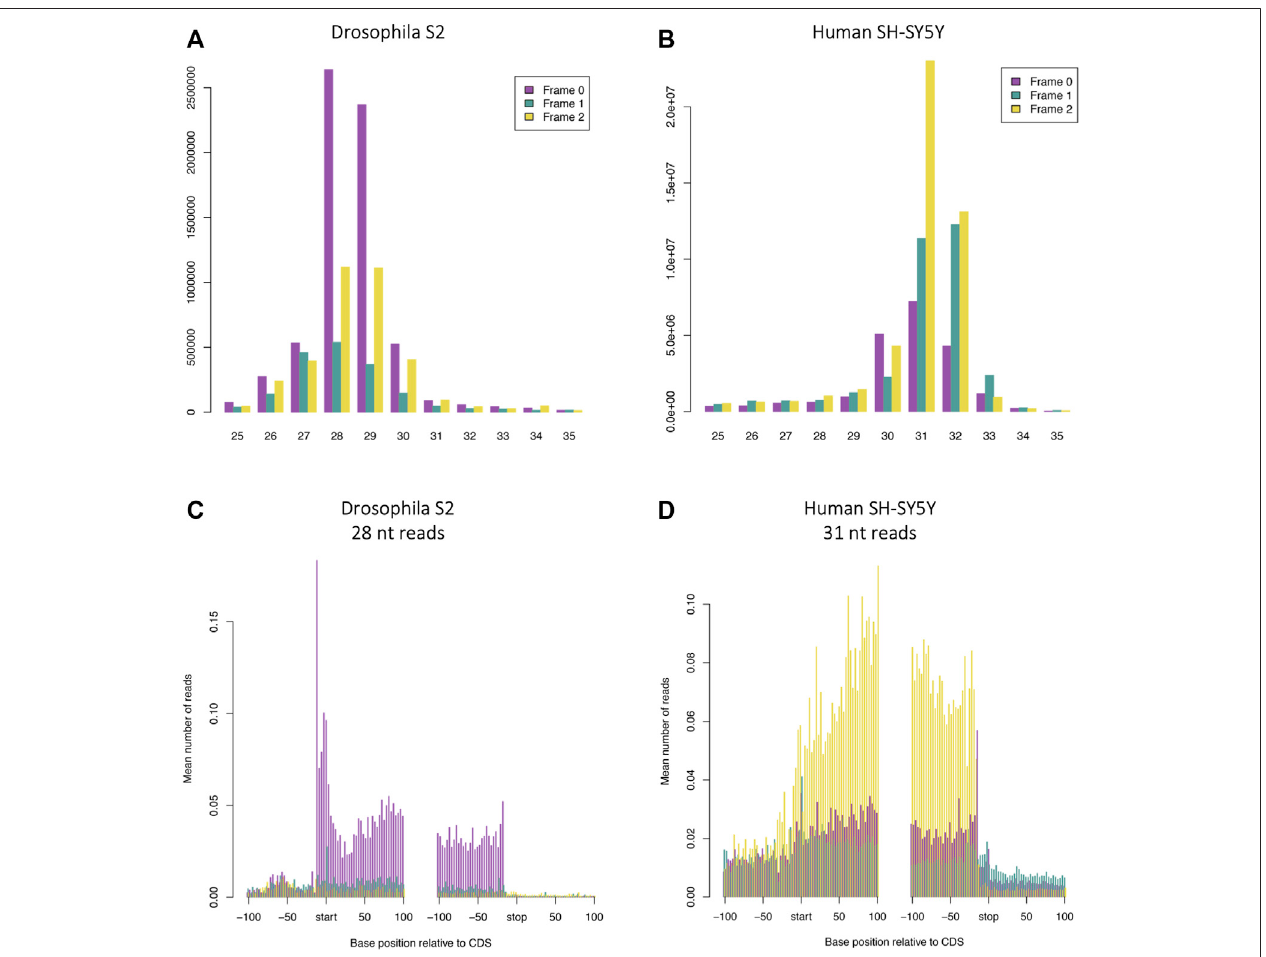
FIGURE 4 | Length of footprints and nature of framing is different between Poly-Ribo-Seq in humans and Ribo-Seq in Drosophila . Read length distribution and framing of ribosome footprinting (A) Drosophila S2 cells ( same as Figure 2B) and (B) human neuroblastoma SH-SY5Y cells ( same as Figure 1G) , with E-RNaseI, in Buffer2 atONat4 ° C,inpresence ofcycloheximide.Metagene analysisofribosome pro fi lingin (C) Drosophila S2cells: 28 ntreads ( sameas Figure2D) and (D) human neuroblastoma SH-SY5Y cells 31 nt reads ( same as Supplementary Figure S3D) . Plots generated with RiboSeqR.